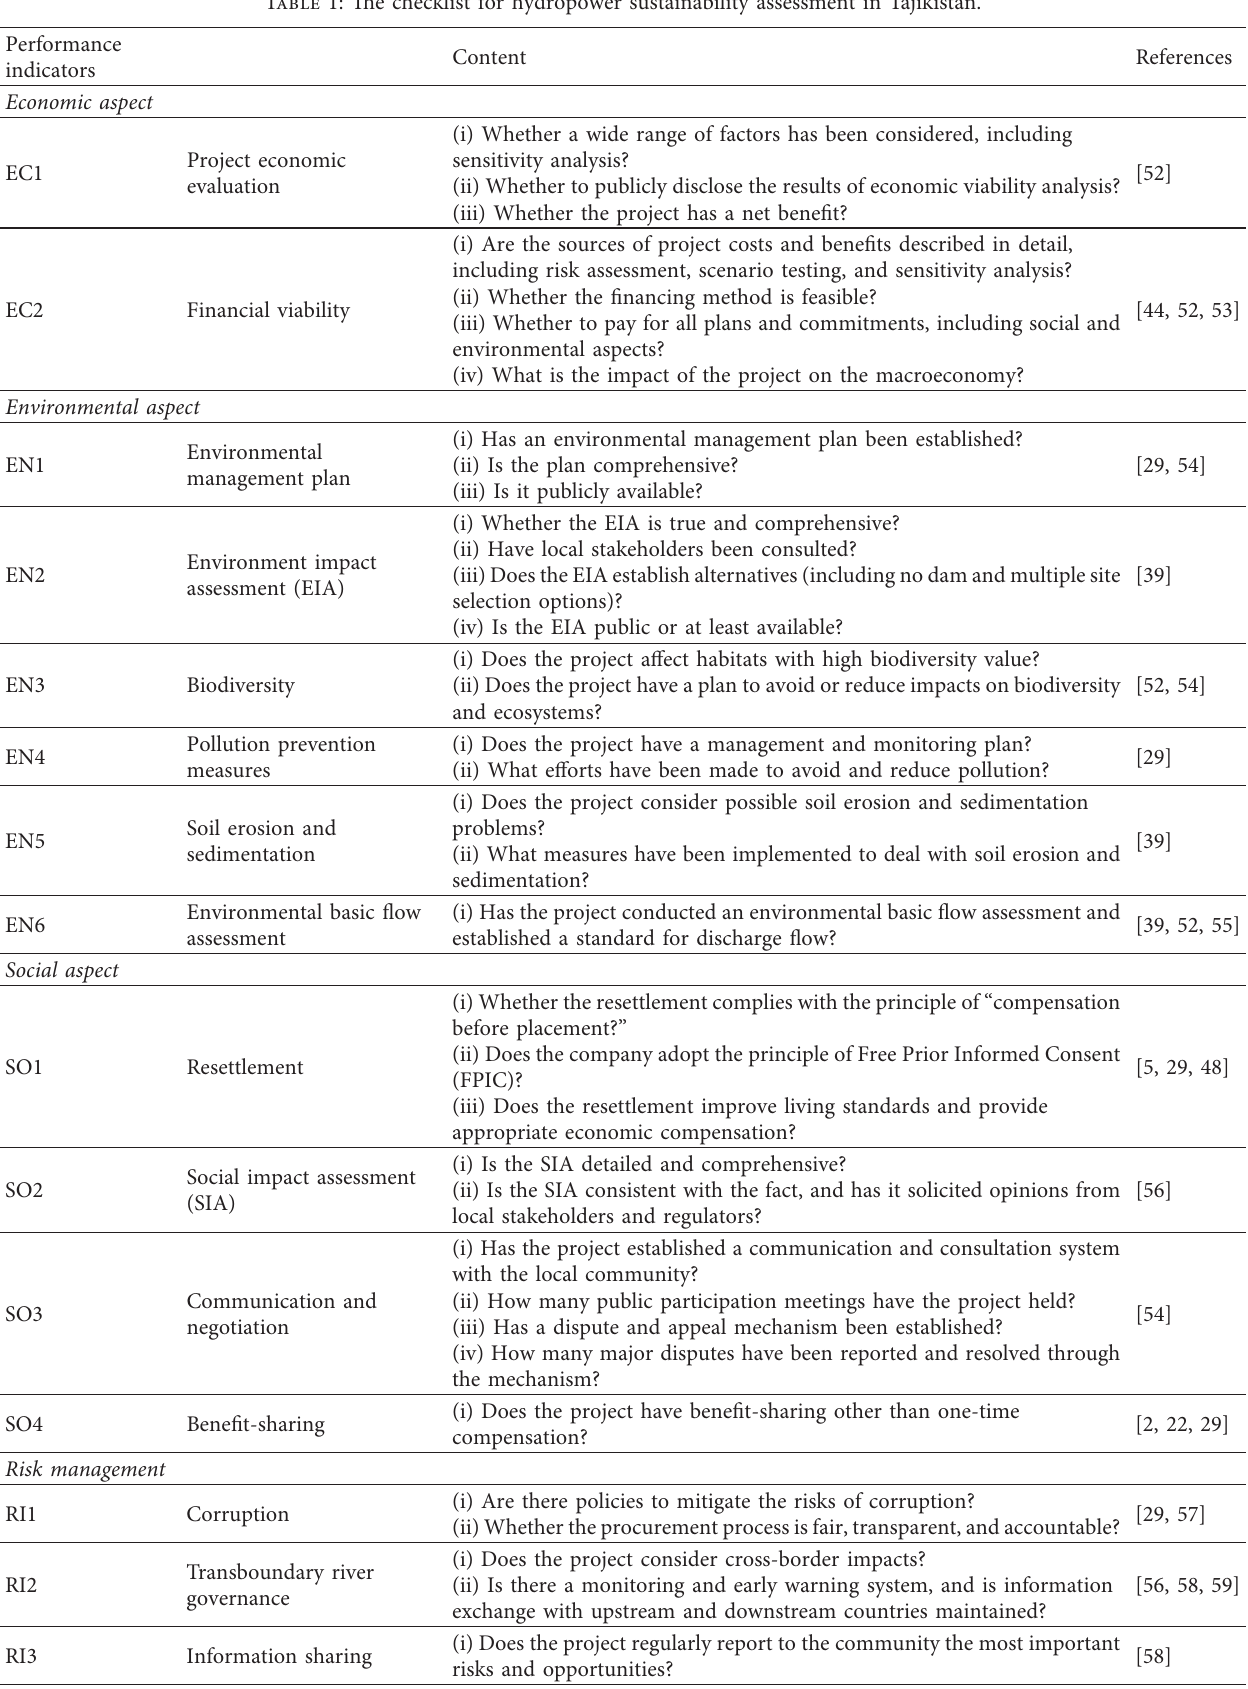
Table 1: The checklist for hydropower sustainability assessment in